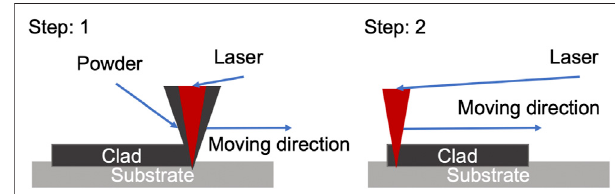
FIGURE 7 | A schematic illustration of the multi-step laser metal deposition. Step-1 represents the laser impinging on the substrate and depositingthepowderinthemeltpool. Step-2 illustratesthelasermeltingand solidifying the same track without powder to homogenize the deposited